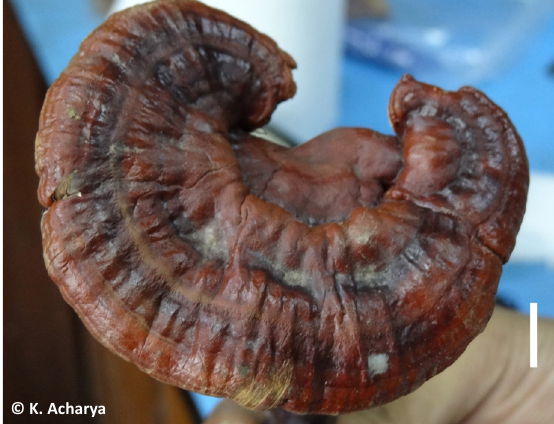
Image 3. Ganoderma flexipes . Scale = 10mm